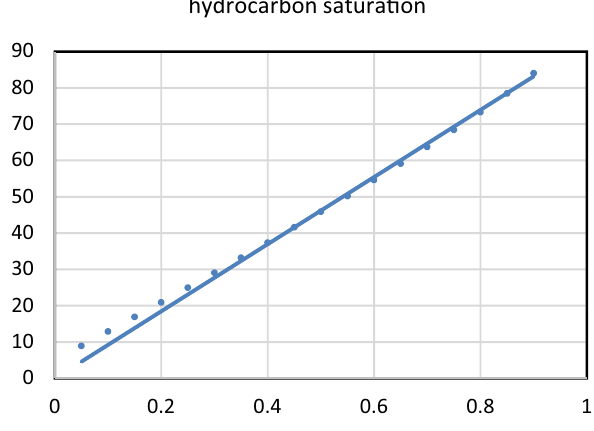
Fig. 25 Hydrocarbon saturation from sonic